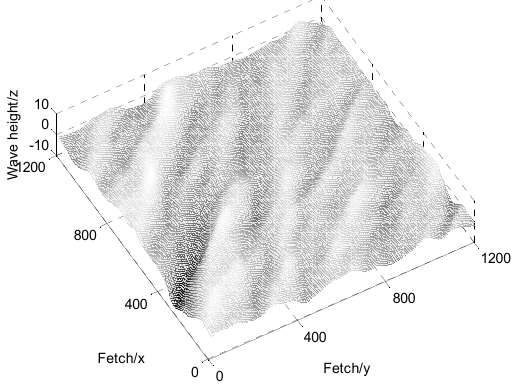
Figure 5. Simulation of 2-D sea surface by fractal method with wind speed 16 km/h, fetch 12 km, wind direction 320° and fractal dimension 1.5.